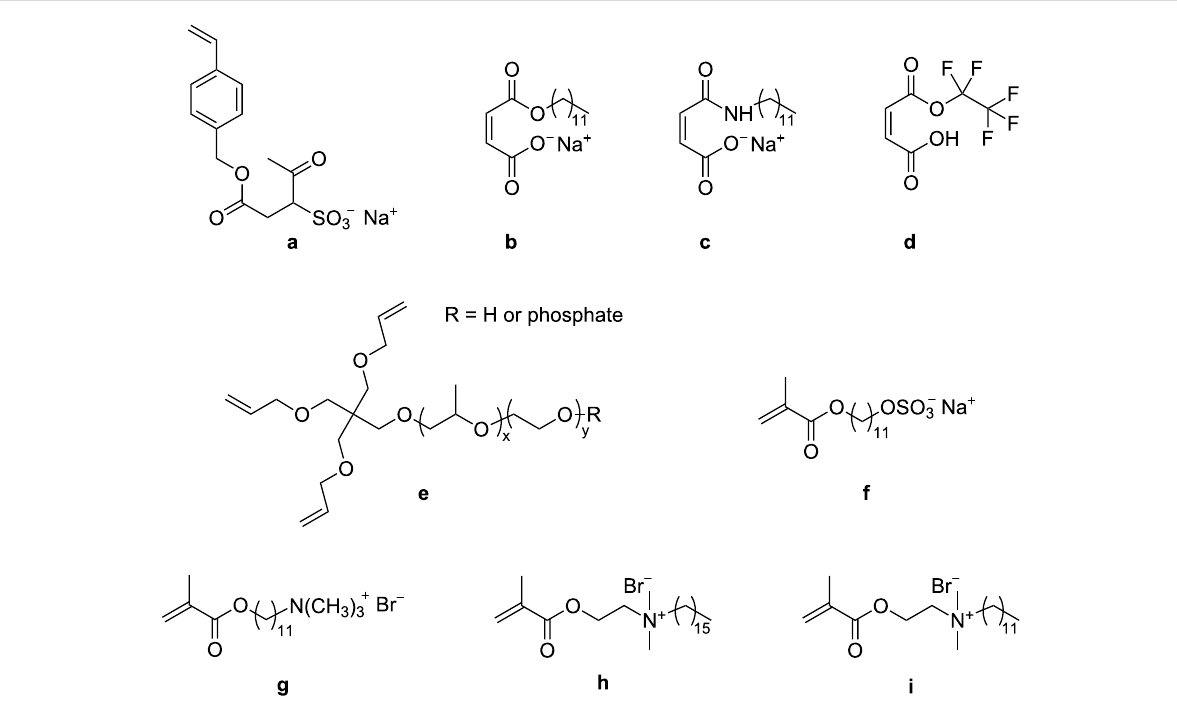
Figure 3: Chemical structures of the surfmers for radical polymerization in miniemulsions: a: sodium vinylbenzylsulfosuccinate [55], b: hemiester and c: hemiamide derivatives of maleic acid [56], d: mono-fluorooctyl maleate [57], e: PEO/PPO containing surfactant [46], f: 11-methacryloyloxyun- decan-1-yl sulfate [58], g: 11-methacryloyloxyundecan-1-yl trimethyl ammonium bromide [58], h: N,N -dimethyl- N - n -hexadecyl- N -methacryloy- loxyethyl ammonium bromide [59], i: N , N -dimethyl- N - n -dodecyl- N -methacryloyloxyethyl ammonium bromide